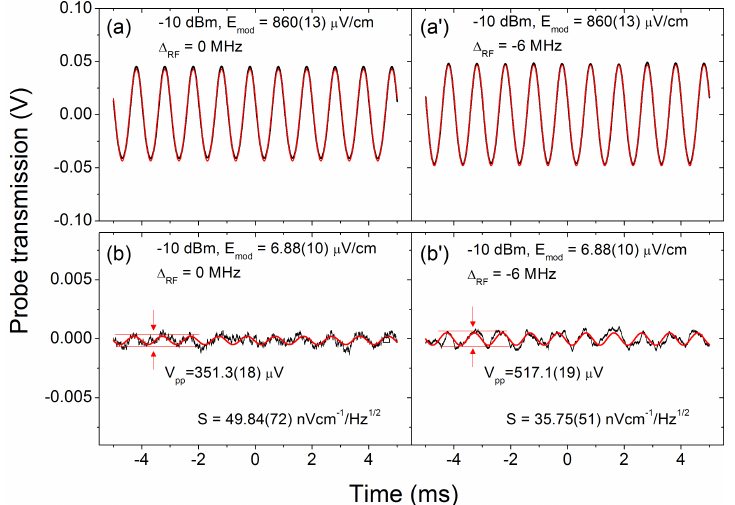
Figure 10. The optical dynamical response at two RF detuning frequencies but all other parameters fixed at the optimized values. The applied amplitude modulation intensity decreases from ( a ) E mod = 860 ( 13 ) µ V/cm down to ( b ) E mod = 6.88 ( 10 ) µ V/cm at LO RF field resonance until approaching the lowest visual perceptible threshold. ( a’ , b’ ) correspond to the case of LO RF detuning of − 6